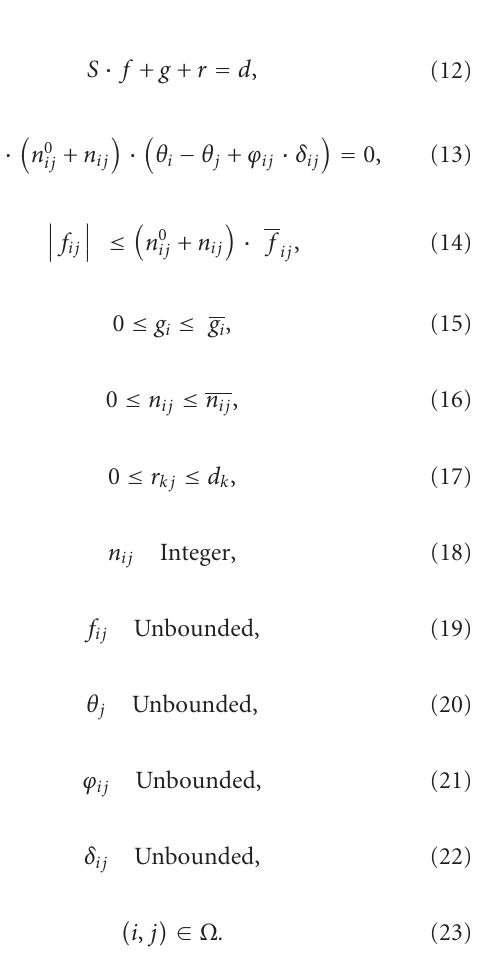
Figure 1: Transmission line.